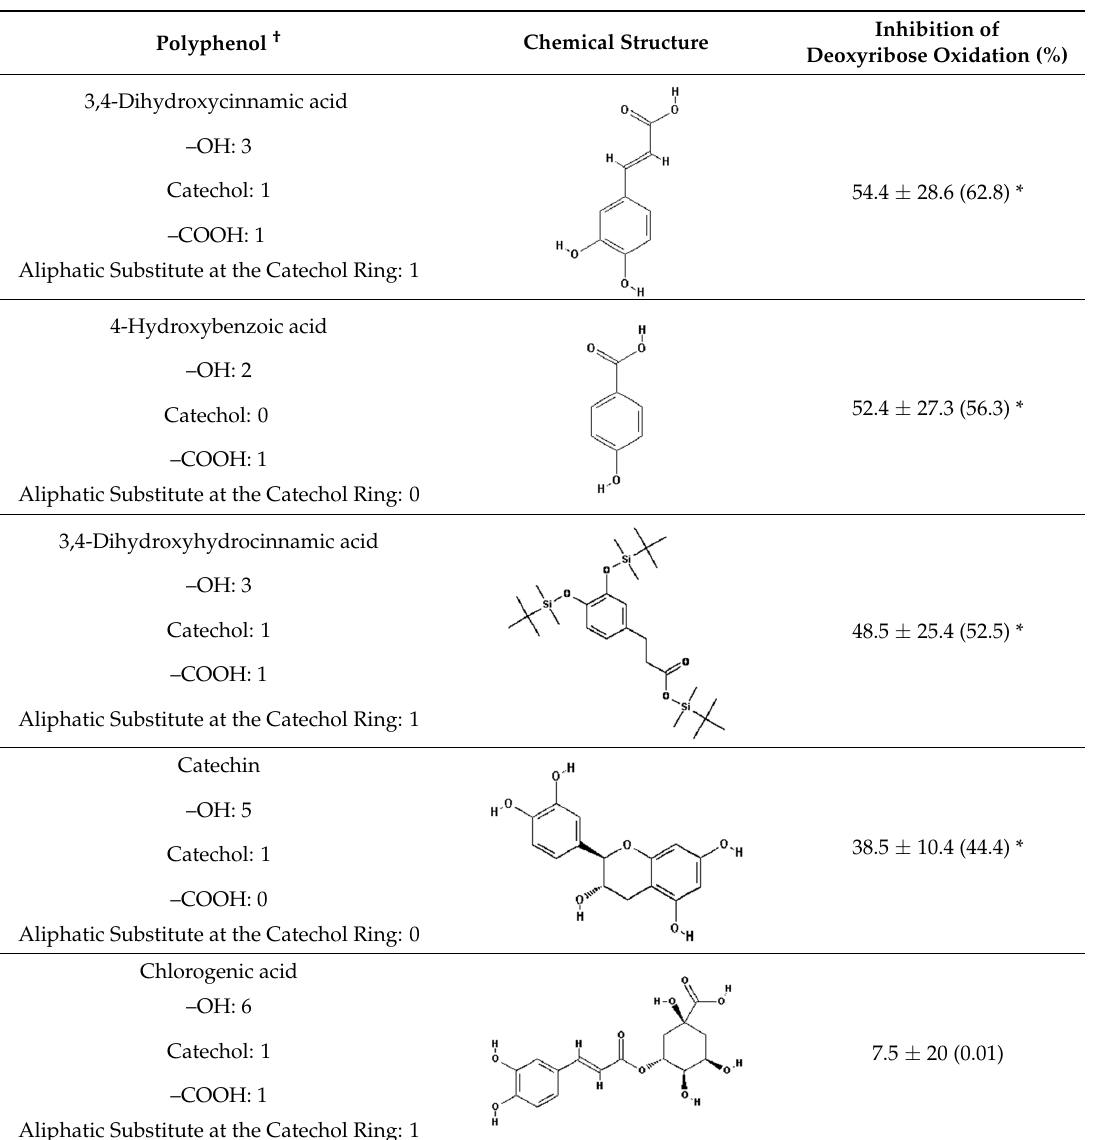
Table 1. Inhibitory (antioxidant) effect of polyphenols on the oxidative degradation of deoxyribose by the system (Fe 2+ -EDTA-H 2 O 2 ).